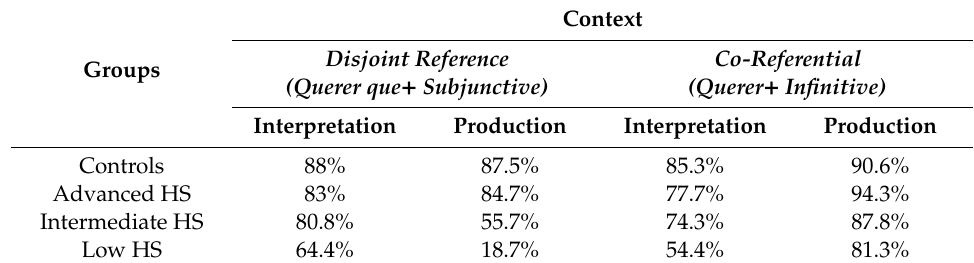
Table 2. Overall accuracy as a function of condition, experimental task and group. (Adapted from Perez-Cortes